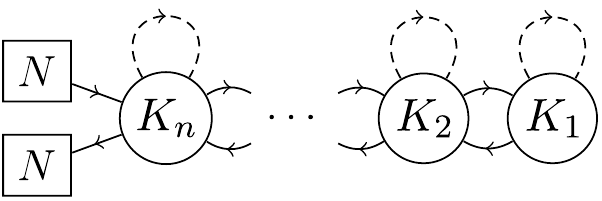
Figure 1 . Linear quiver diagram corresponding to a 2d N = (2 ; 2) GLSM. Its (cid:12)eld content con- sists of U( K i ) 2d vector multiplets for i = 1 ; : : : ; n , N fundamental (cid:30) fund